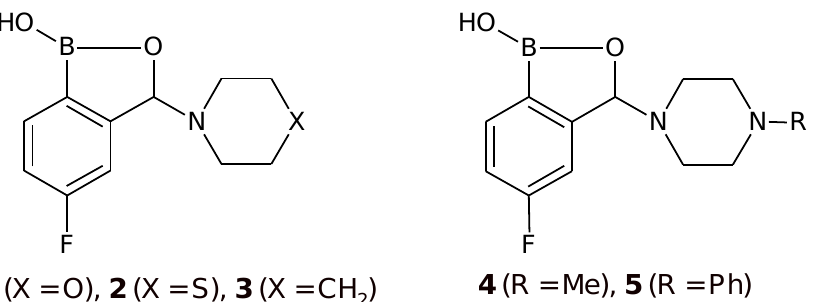
Figure 2. Structures of studied Tavaborole’s derivatives ( 1–5 ).